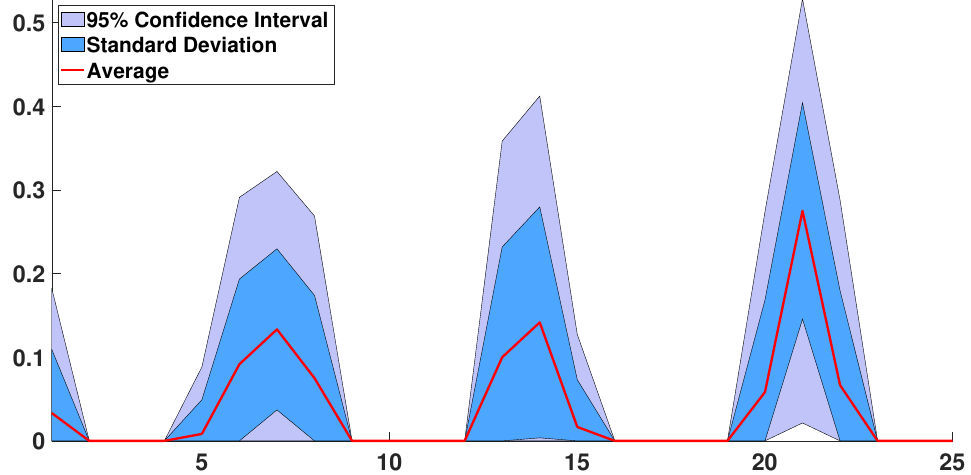
Figure 15. In this figure, we consider the case n = 25. we plot the distributions of daily basic repro- duction numbers d (cid:55)→ R 0 ( d ) corresponding to the distributions having some secondary eigenvalues and fourth eigenvalues at a distance less than 10 − 2 to the best match. The red curve is the average distribution d (cid:55)→ R 0 ( d ) . The blue region corresponds to the standard deviation around the mean distribution. The light blue region corresponds to the 95% confidence interval.